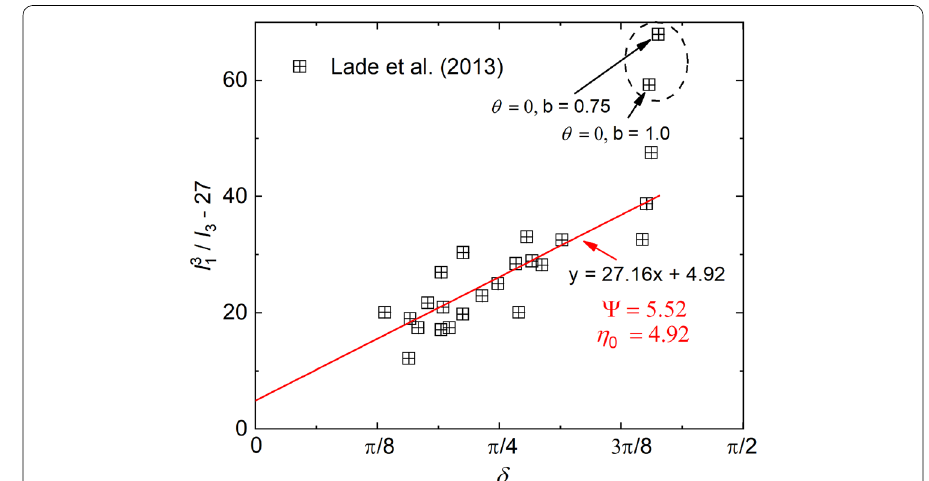
Fig. 10 Model calibration for constant mean effective stress